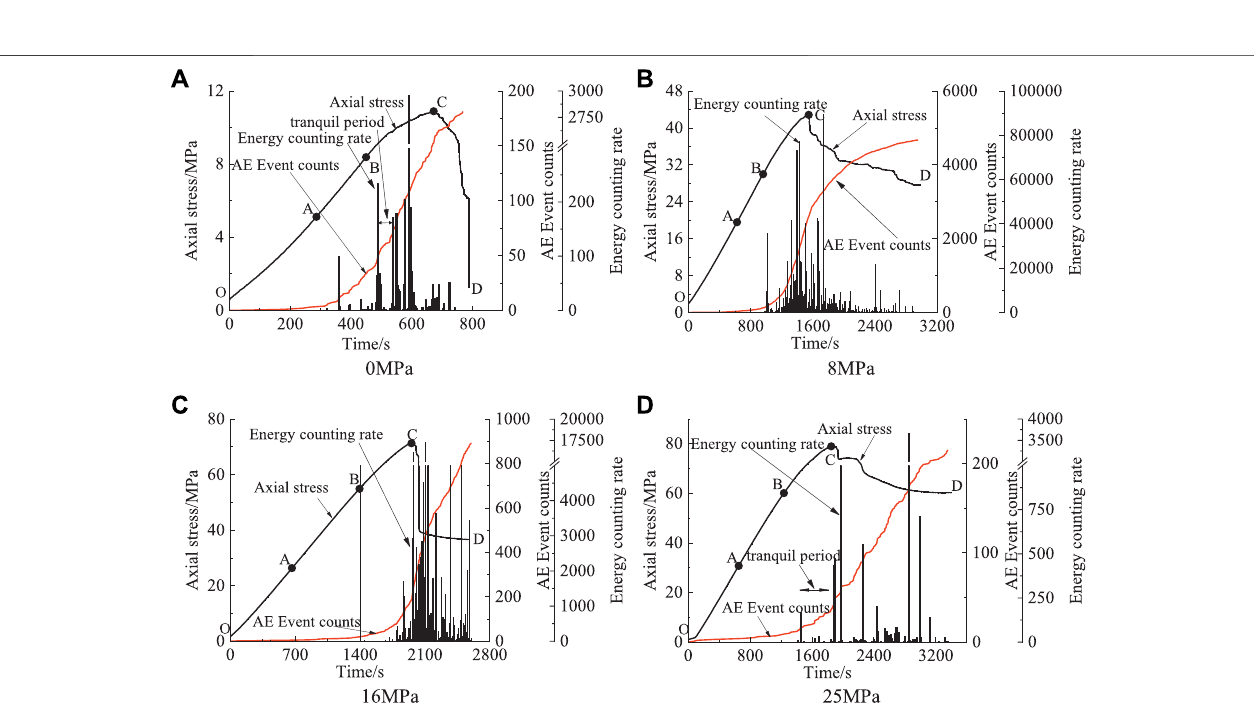
FIGURE 6 | Acoustic emission characteristics of coal under different con fi ning pressures. (A) 0 MPa, (B) 8 MPa, (C) 16 MPa, and (D) 25 MPa.